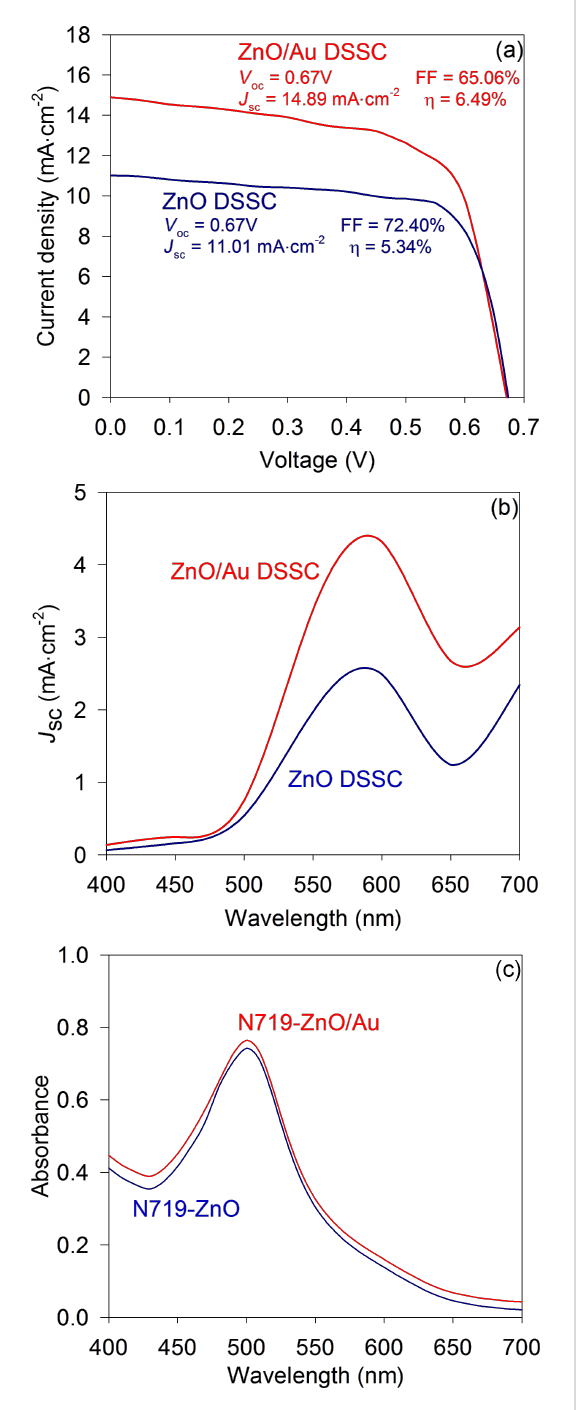
Figure 3: (a) J–V characteristics of the bare ZnO-nanorod and ZnO/Au-nanocomposite DSSCs, measured at 1 sun, AM 1.5 G illumi- nation, (b) short-circuit photocurrent density of the bare ZnO-nanorod and ZnO/Au-nanocomposite DSSCs measured at different incident wavelengths and (c) optical absorptions of dye N719 in 0.1 mM KOH aqueous solution for bare ZnO-nanorod and ZnO/Au-nanocomposite photoelectrodes. The optical absorption was measured by removing the dye molecules from the respective photoelectrodes (size = 1 cm 2 ) by dipping them in a 0.1 mM KOH aqueous solution (2 mL) for 5 min.